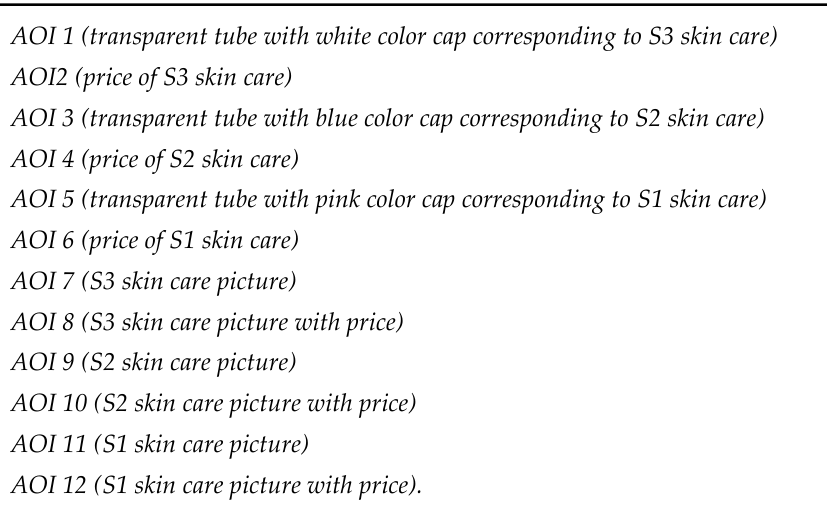
Table 1. AOI 2 ANOVA test S3 Price.